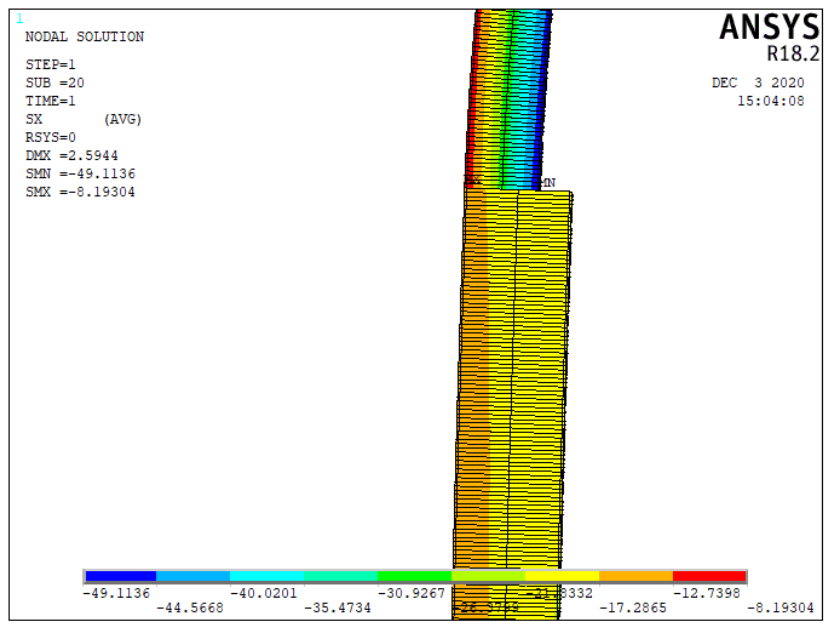
Figure 8. Shear force of the steel bent frame column.